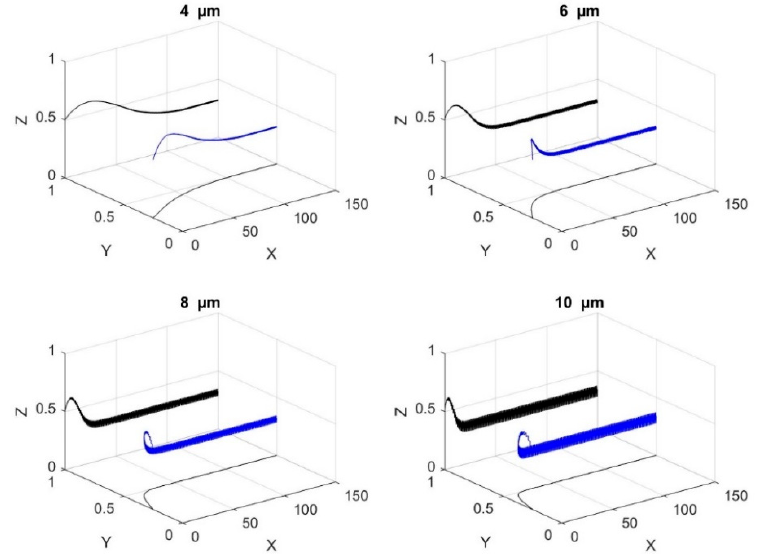
Figure 5. The impact of the size of the microparticle on its trajectory along the microchannel (4 µ m, 6 µ m, 8 µ m, 10 µ m). The projections on the planes xy and xz are shown. X, Y, and Z are the dimensionless lengths x / L, y / L, and z / Hch, respectively.